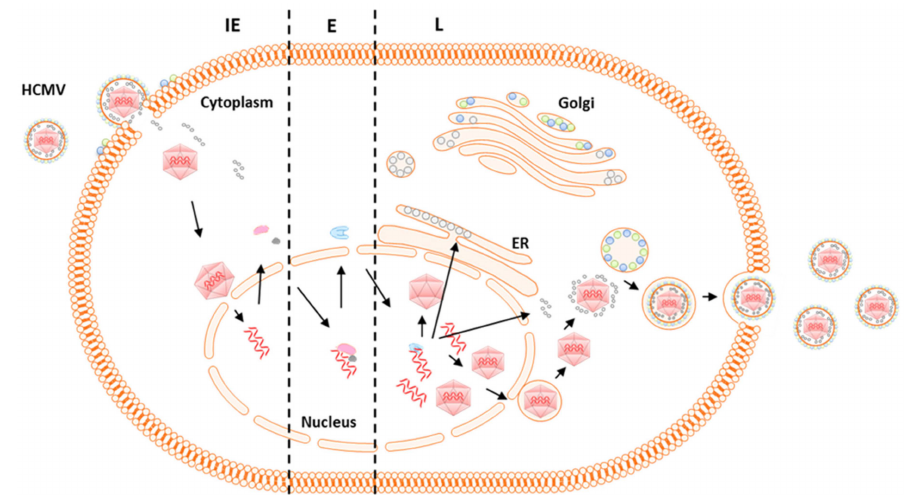
Figure 1. Human cytomegalovirus (HCMV) life cycle. HCMV enters the cell through interaction of the host receptors with specific viral glycoproteins. Capsid and tegument proteins are release into the host cytosol. The capsid releases the viral genome into the nucleus, leading to the expression of immediate early (IE) genes. The IE proteins activate the expression of the early (E) genes. The E proteins initiate viral genome replication and the expression of late (L) genes. The L gene expression initiates the capsid assembly and the expression of tegument- and glycoproteins. The genome-loaded capsid enters the cytosol via nuclear egress. The capsid associates with the tegument proteins. The capsid acquires the viral envelope by budding into intracellular vesicles. The enveloped viral particles are released into the extracellular space.